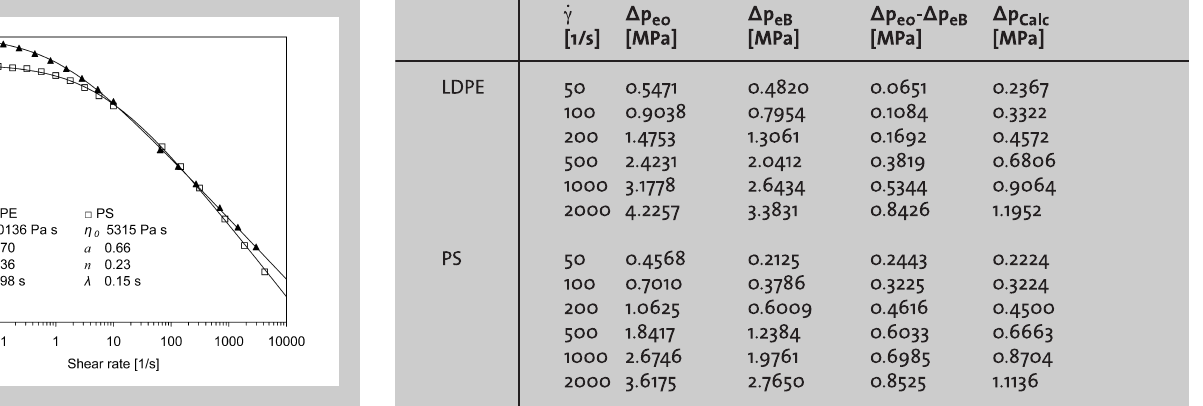
Figure 5: Viscosity data for LDPE and PS measured by capillary rheometer (high shear rates) and rotational rheometer (low shear rates), and the best fits to the data sets according to the Carreau- Yasuda model, Eq. 6 (fitting parameters are shown in the figure). Table 2: Entrance pressure drop measured with orifice die, D p , extrapolated from e0 , differ- Bagley plots, D p eB ence between them, D p – e0 D p , and calculated pres- eB sure drop values for the out- let region of the orifice die, D p Calc